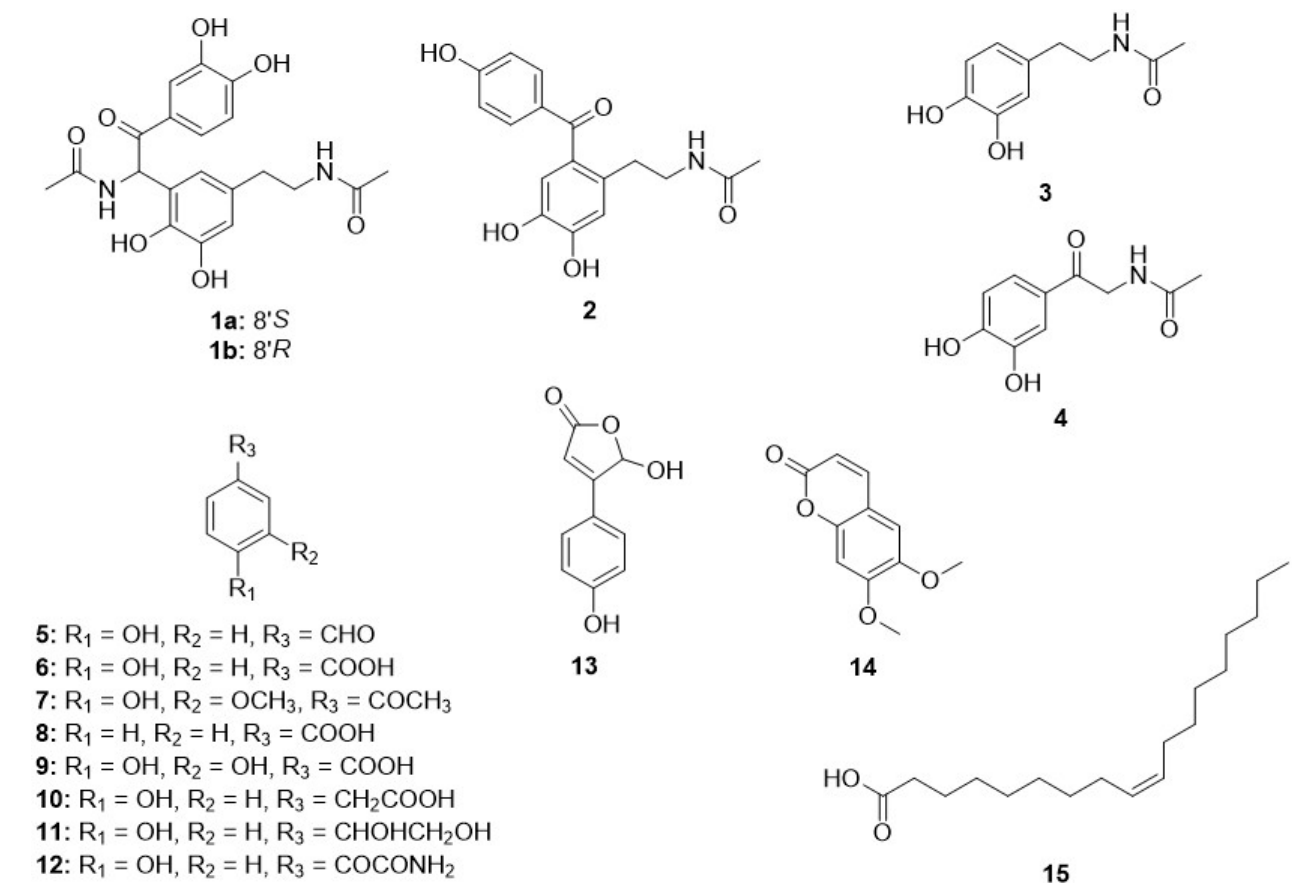
Figure 1. All isolated compounds from a 70% EtOH extract of T . angustipennis egg cases. Compound 1 was obtained as a brown gum, and HRESIMS analysis revealed its elemental formula to be C 20 H 22 N 2 O 7 , suggesting eleven degrees of unsaturation. The 1 H NMR data indicated the presence of two methyl groups ( δ H 1.80 (3H, s, CH 3 -10) and 2.02 (3H, s, CH 3 -10 ′ )), two methylene groups ( δ H 2.55 (2H, t, J = 7.2 Hz, H-7) and 3.24 (2H, t, J = 7.2 Hz, H-8)), a methine group ( δ H 6.66 (1H, s, H-8 ′ )), two meta -coupled aromatic methine groups ( δ H 6.61 (1H, d, J = 1.8 Hz, H-2) and 6.39 (1H, d, J = 1.9 Hz, H-6)), and three aromatic methine groups in an ABX spin system ( δ H 6.72 (1H, d, J = 8.4 Hz, H-5 ′ ), 7.44 (1H, d, J = 2.0 Hz, H-2 ′ ), and 7.47 (1H, dd, J = 8.4, 2.1 Hz, H-6 ′ )) (Table 1). The 13 C NMR data corresponded to 20 carbons, including two methyl carbons, two methylene carbons, six methine carbons, three carbonyl carbons, and seven additional quaternary carbons (Table 1). The 1 H and 13 C NMR data for compound 1 were similar to those for the dimeric N -acetyldopamine derivative polyrhadopamine B [14], except that the 2-oxo- N -acetyldopamine ( 4 ) unit linked at C-6 in polyrhadopamine B was linked at C-5 in compound 1 . This result was supported by the presence of two doublet proton signals with meta coupling at H-2 ( δ H 6.61) and H-6 ( δ H 6.39), as well as the HMBC correlations between H-6/C-8 ′ ( δ C 54.4), C-7 ( δ C 36.0), C-2 ( δ C 116.8), and C-4 ( δ C 142.8) and those between H-8 ′ /C-6 ( δ C 120.3), C-4 ( δ C 142.8), C-5 ( δ C 125.3), C-9 ′ ( δ C 173.2), and C-7 ′ ( δ C 196.3) (Figure 2).